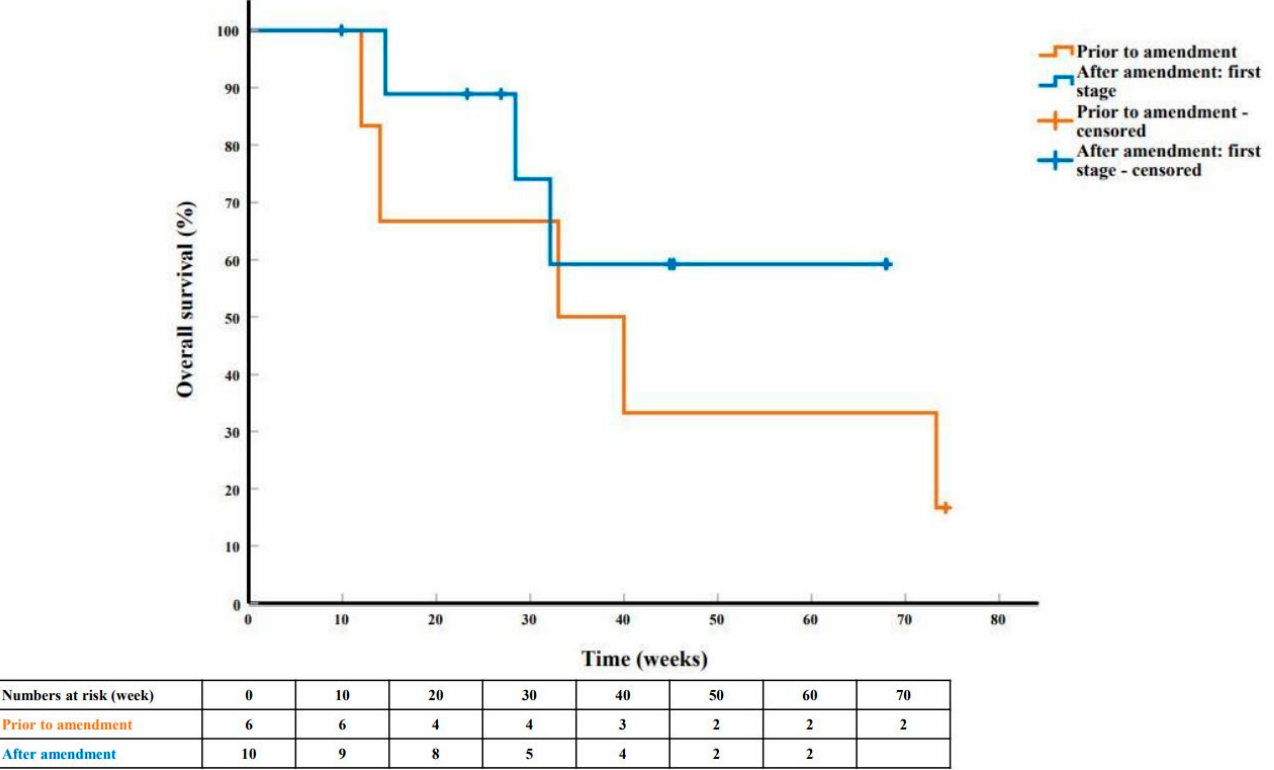
Figure 4. Overall survival curve and life table in the first six patients enrolled prior to trial amendment (orange) and in the ten patients enrolled after trial amendment in the first stage of the study (blue).